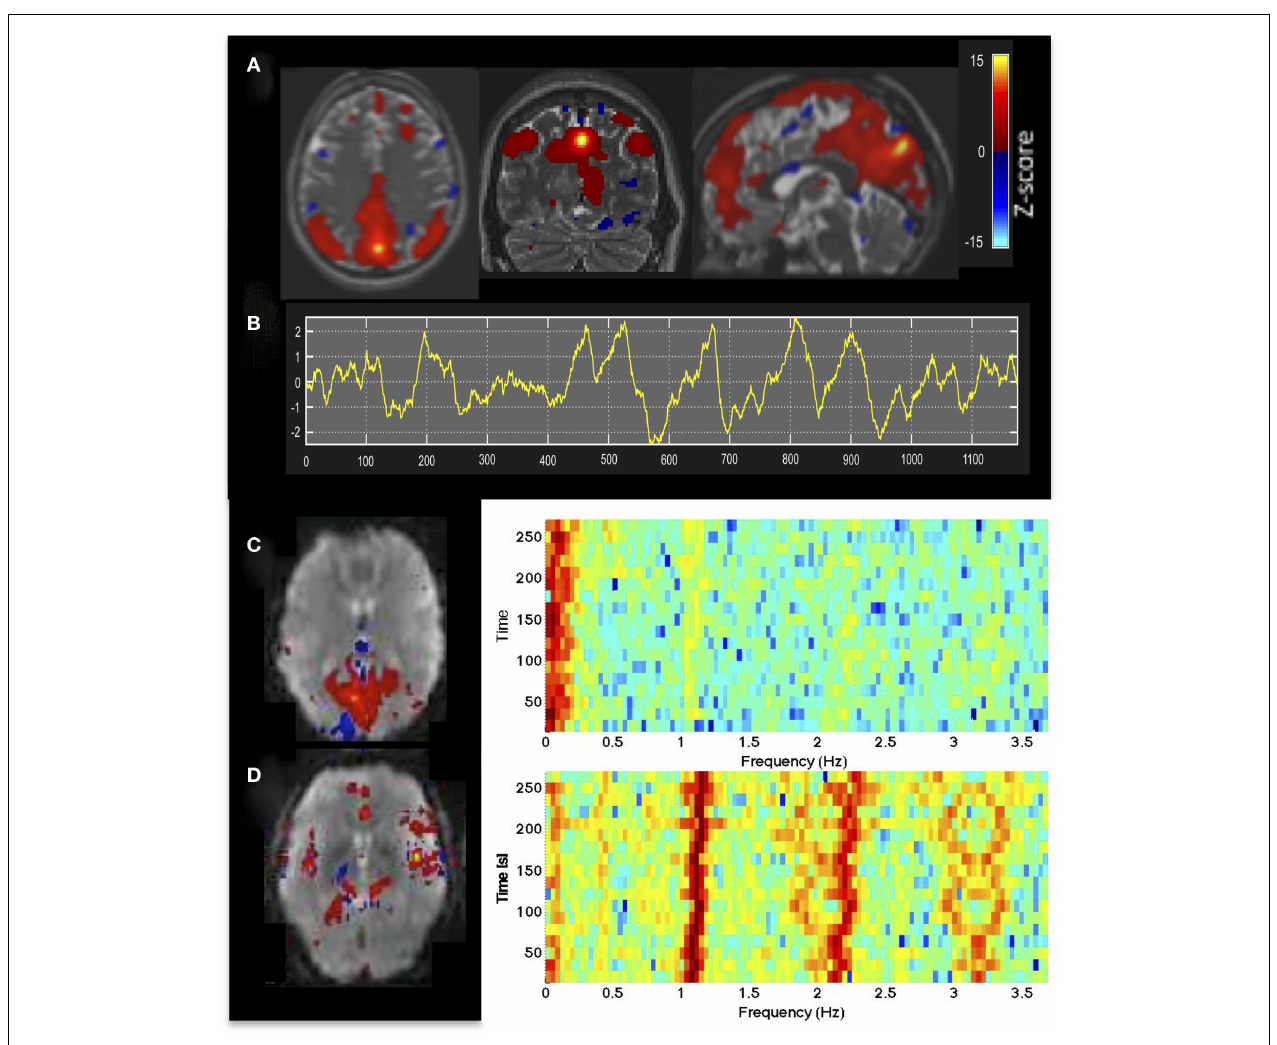
changes well above noise level ( z max > 10) distinguish (C) RSNs from (D) cardiac-related signal pulsation.The corresponding spectrograms display (C) the dynamically fluctuating low-frequency power spectrum of the RSN and (D) the first and second harmonics of the cardiac pulsation.